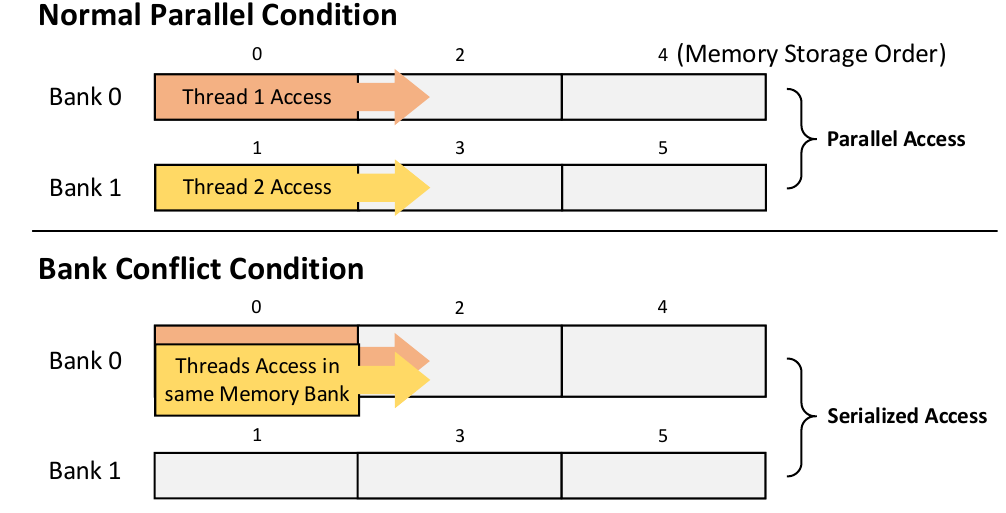
Figure 9. Bank conflict condition.